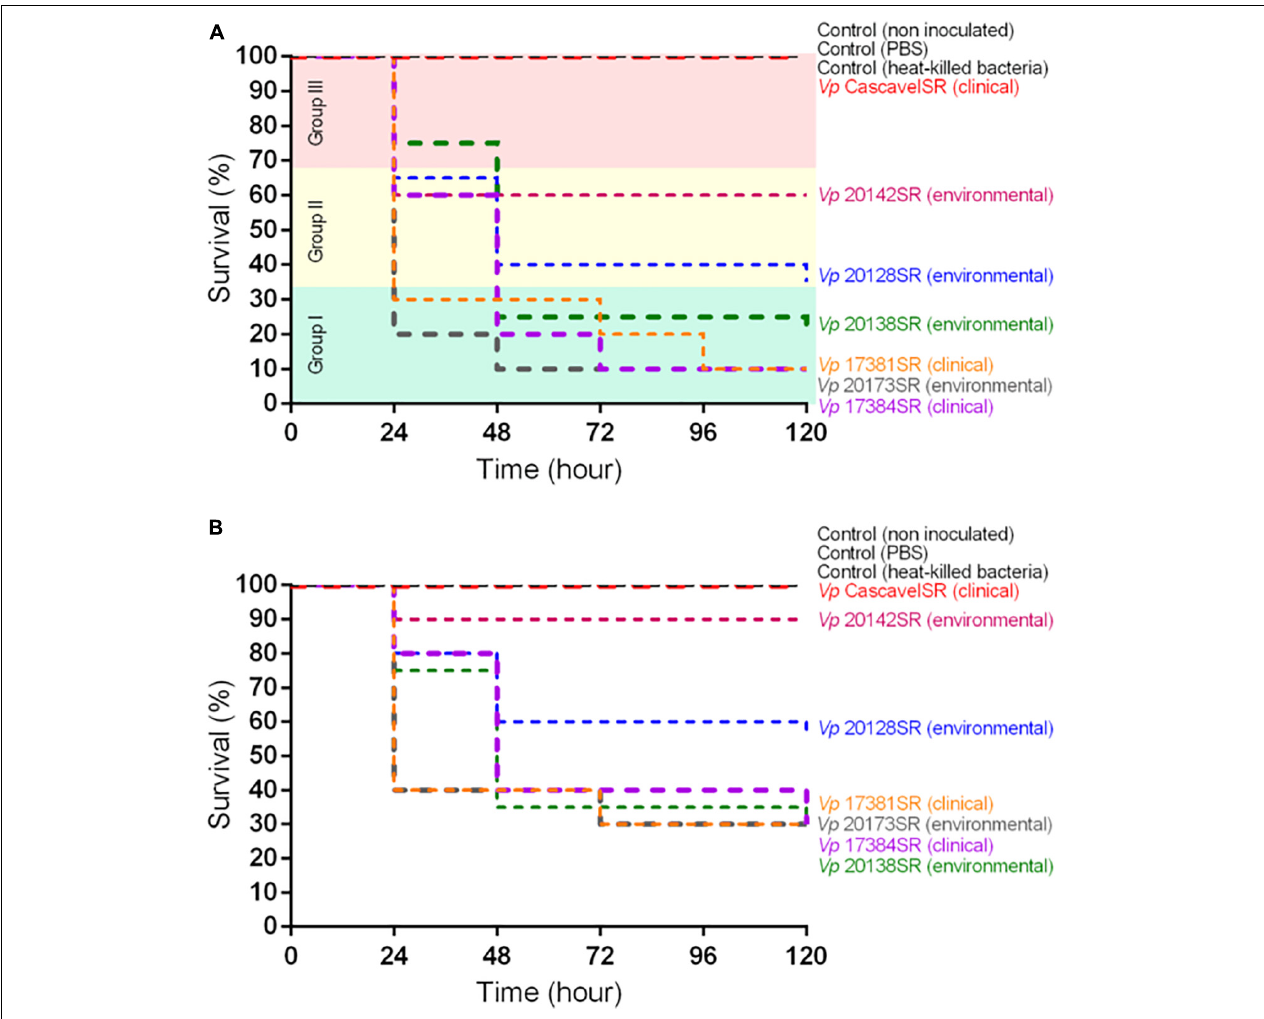
FIGURE 2 | Survival curves of Galleria mellonella larvae inoculated with (A) 10 4 CFU/larva and (B) 10 3 CFU/larva of each of the seven Vibrio parahaemolyticus strains. Each group contained n = 20 larvae per dose of each strain. Three controls, with n = 10 larvae per group, were used: non-inoculated, inoculated with phosphate-buffered saline, and heat-killed bacteria. Strains were grouped according to virulence: group I (green) – high; group II (yellow) – intermediate; and group III (red) – low. Survival curves of larvae in each group were generated using the Kaplan–Meier method (Kaplan and Meier, 1958) and compared using the log-rank test (Mantel, 1966; Peto and Peto, 1972), with p -values < 0.05 considered statistically significant.